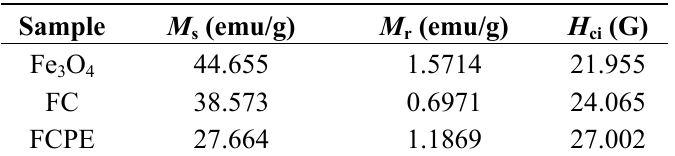
Table 1. Magnetic properties of iron oxide nanoparticles and iron oxide coated with chitosan-prindopril erbumine